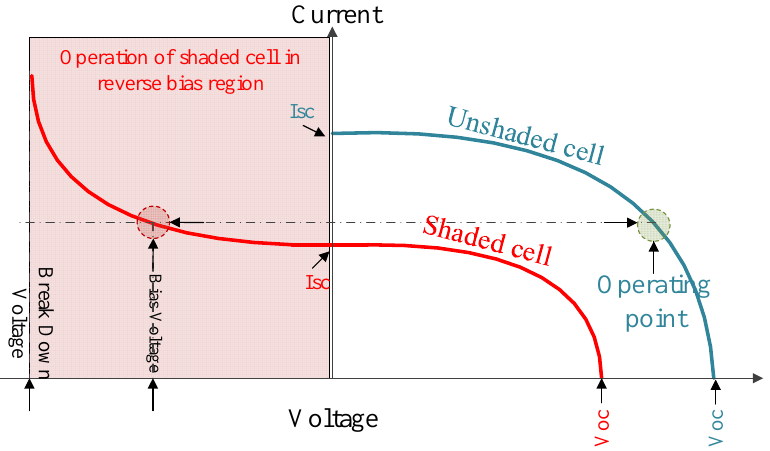
Figure 3. Current ‐ Voltage correlation of a PV cell in the reverse bias region.